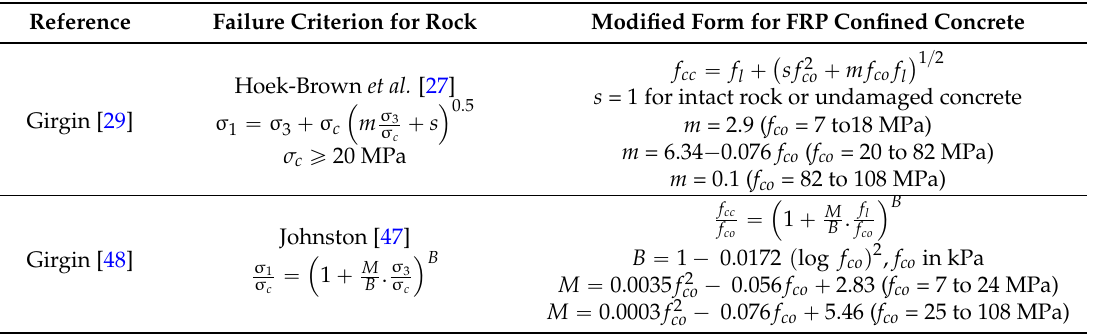
Table 2. Modified strength models from rock